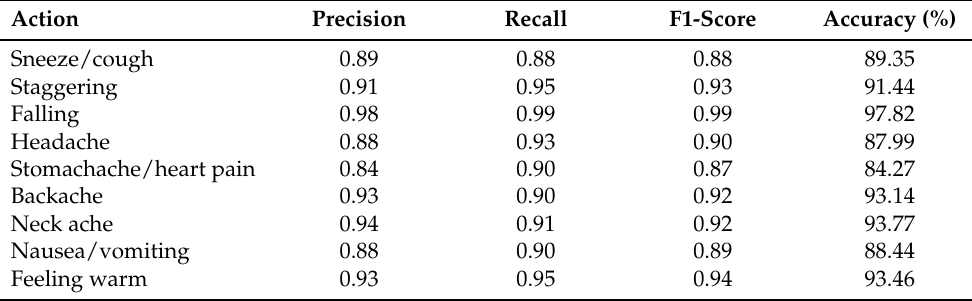
Table 5. Classification report of STGCN of healthcare-related actions in the X-view subset.